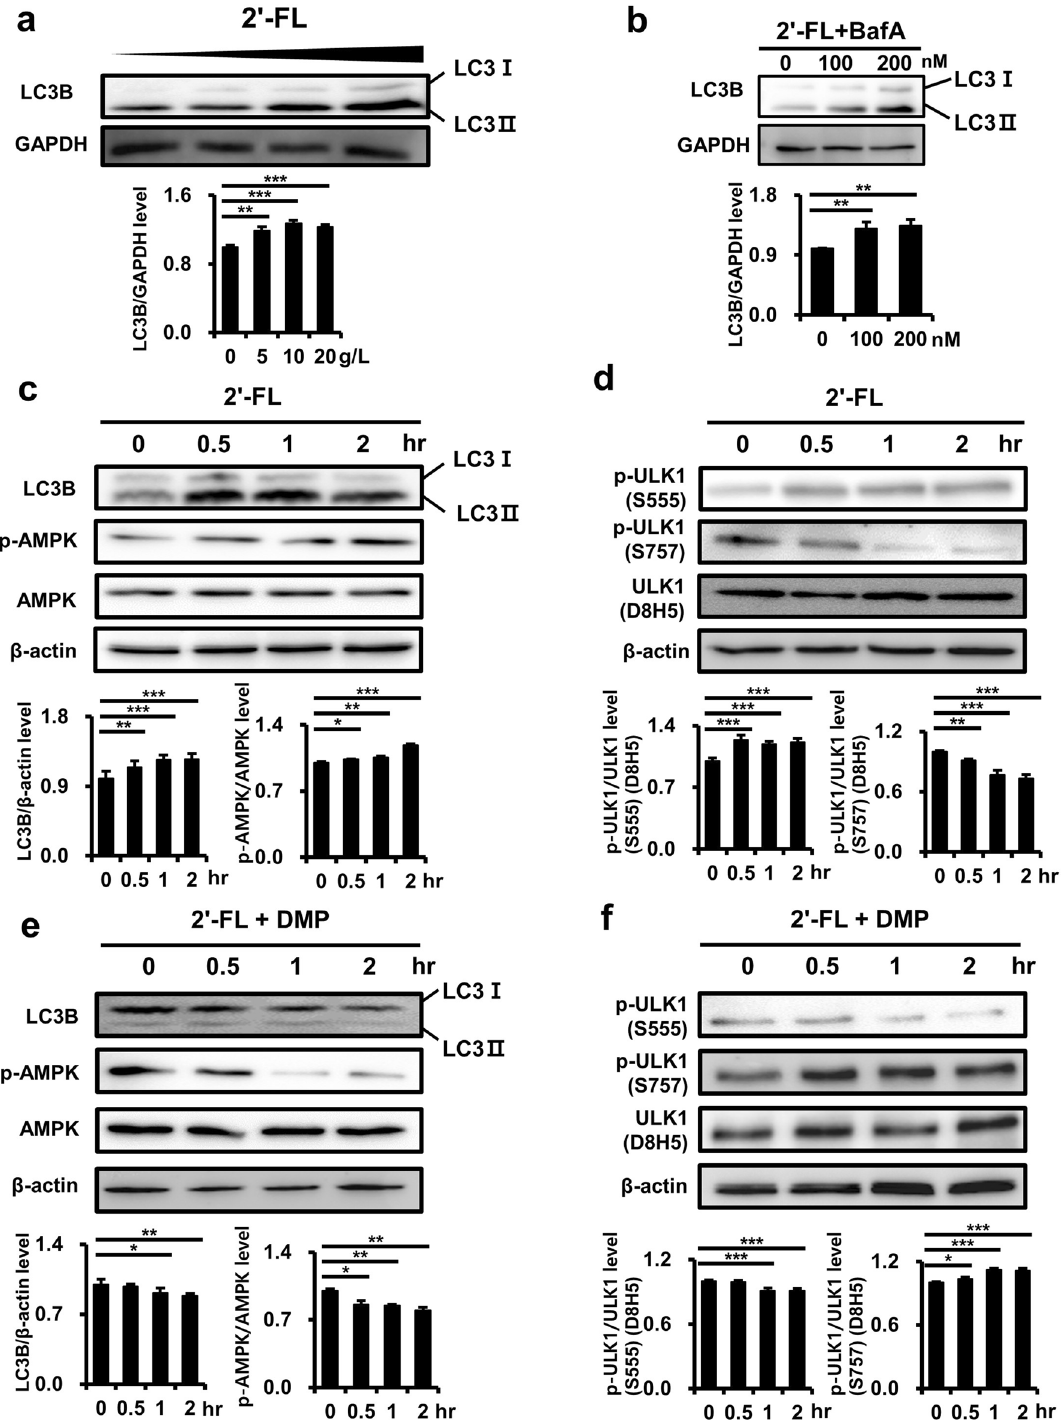
Figure 3. 2’-Fucosyllactose induces autophagy via the phosphorylation of AMPK and ULK1. ( a ) Western blot analysis of LC3II levels in human MNT-1 cells treated with 2’-FL (0, 5, 10 or 20 g/L) for 2 h. ( b ) Western blot analysis of LC3 protein levels in MNT-1 cells treated with 2’-FL (20 g/L) and Baf A (0, 100, and 200 nM) for 2 h. ( a , b ) The graph indicates the relative protein levels of LC3B normalized by GAPDH. ( c – f ) Western blot analysis of LC3II, total AMPK, and phosphorylated AMPK (Thr172) ( c , e ) as well as of total and phosphorylated (Ser555 and Ser757) ULK1 ( d , f ) in human MNT-1 melanoma cells treated with 2’-FL (20 g/L) alone ( c , d ) or plus dorsomorphin (10 µM, DMP) ( e , f ) for 0, 0.5, 1, and 2 h. ( c , e ) Phosphorylation level of LC3B normalized by β-actin and phosphorylation level of AMPK normalized by AMPK. ( d , f ) Phosphorylation level of ULK1 normalized by ULK1, * P < 0.05, ** P < 0.01, *** P < 0.001 by Student’s t -test.” (Also see Supplementary Fig. 2). LC3, microtubule-associated protein 1A/1B-light chain 3; Baf A, Bafilomycin A; AMPK, adenosine monophosphate activated protein kinase; ULK1, Unc-51-like autophagy activating kinase